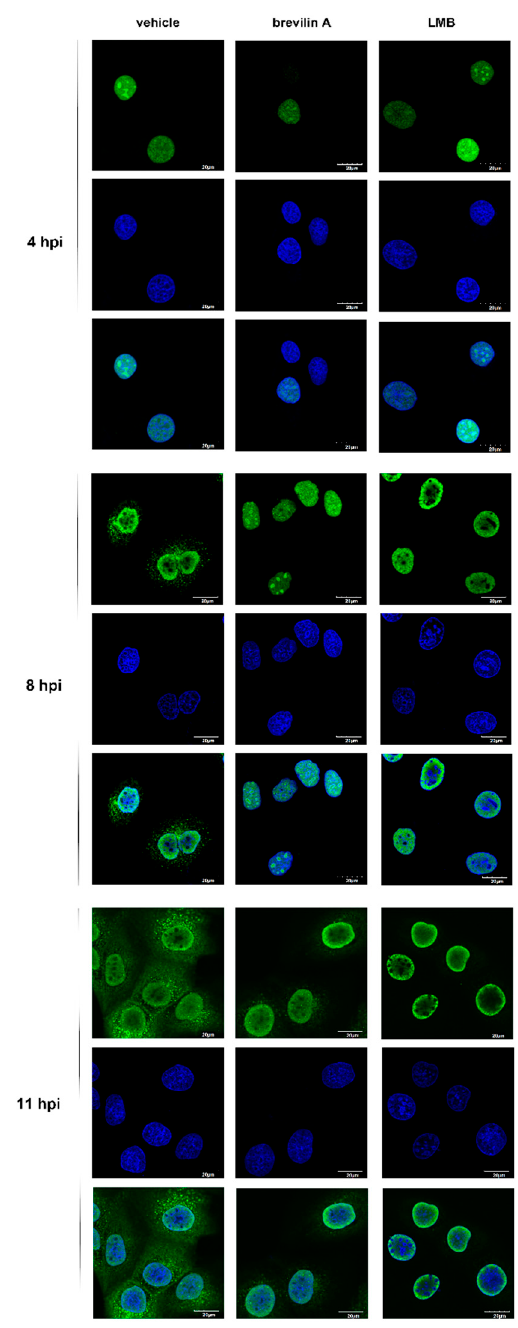
Figure 6. The effects of brevilin A on the viral ribonucleoproteins (vRNP) localization. MDCK cells were infected with PR8 at a MOI of 3 and then treated with brevilin A, LMB, or vehicle as indicated. Samples were fixed at 4, 8, or 11 hpi, and then stained with anti-NP body (green) and DAPI (blue). Immunofluorescence was observed with confocal microscopy. The scale bar in the images is 20 μ m.